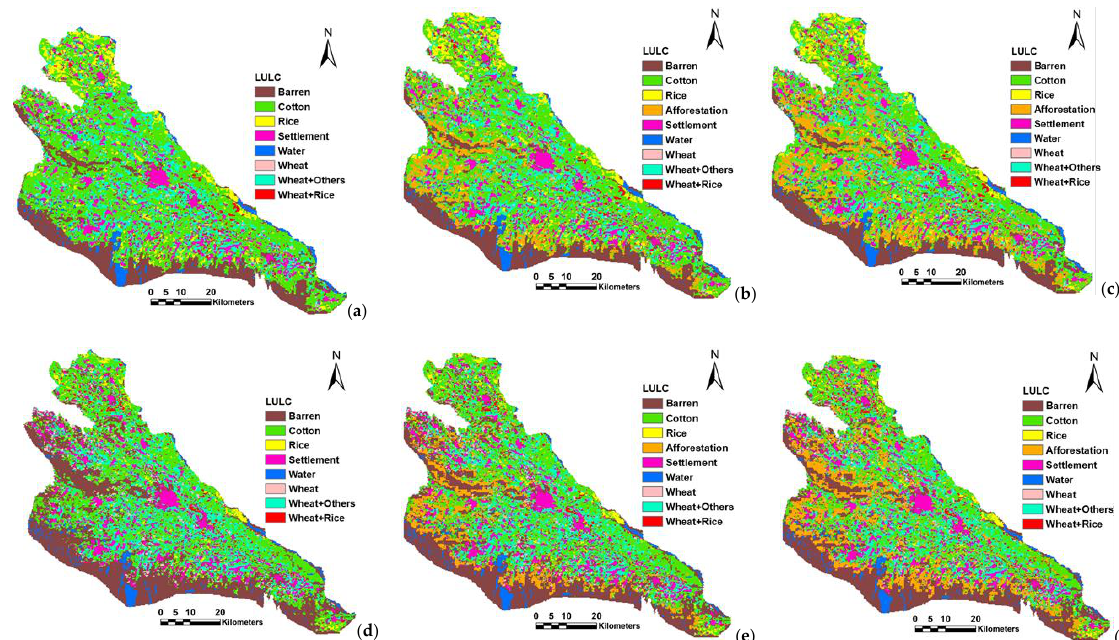
Figure 6. Land use map for 2005 representing average conditions ( a ), 62% afforestation (2005) ( b ), 100% afforestation (2005) ( c ), land use map 2008, representing drought conditions ( d ), 62% afforestation (2008) ( e ), and 100% afforestation (2008) ( f ). Source: [49].